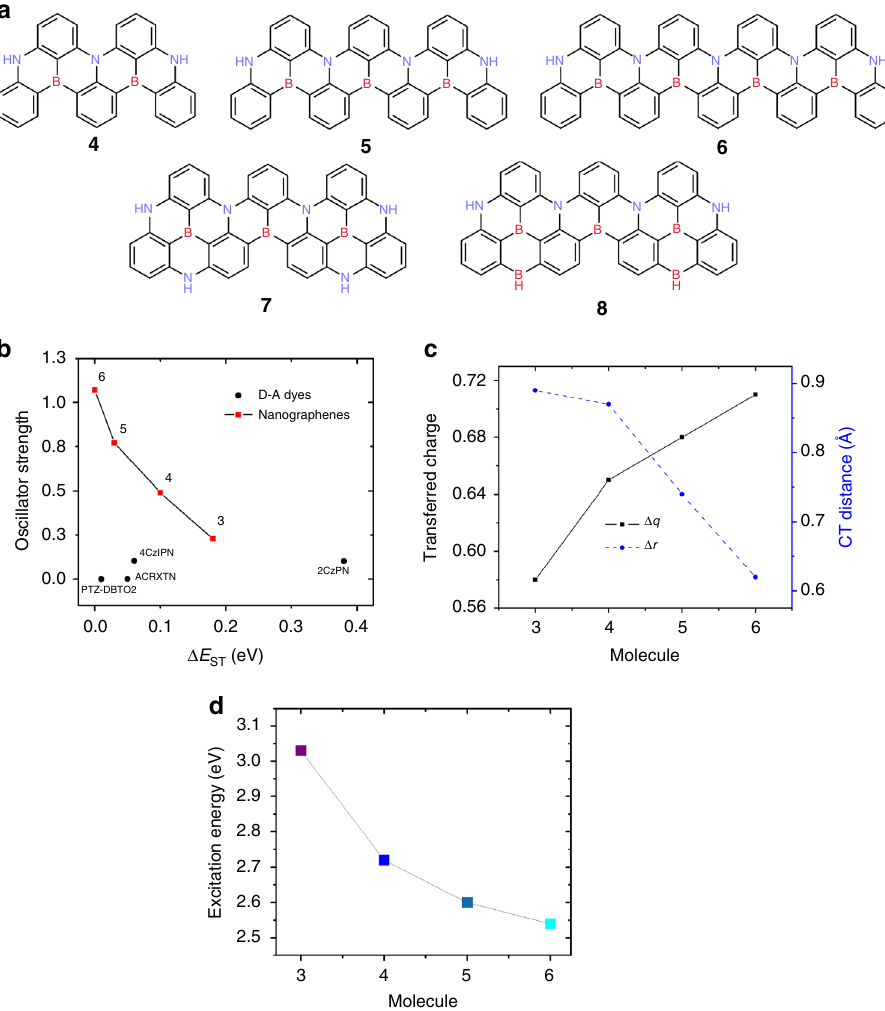
Fig. 3 Excited state properties for the designed boron-doped and nitrogen-doped π -extended nanographenes. a Chemical structures of engineered molecules 4 – 8 . Compound 3 coincides with fr5 in Fig. 2a. b Oscillator strength, f osc , as a function of Δ E ST for 3 – 6 (red squares) against conventional D-A reference TADF emitters (black dots, see chemical structures in Supplementary Fig. 3). c Transferred charge (in |e|) and CT distance (Å), as computed for molecules 3 – 6 . d Emission energies and respective colors for 3 –